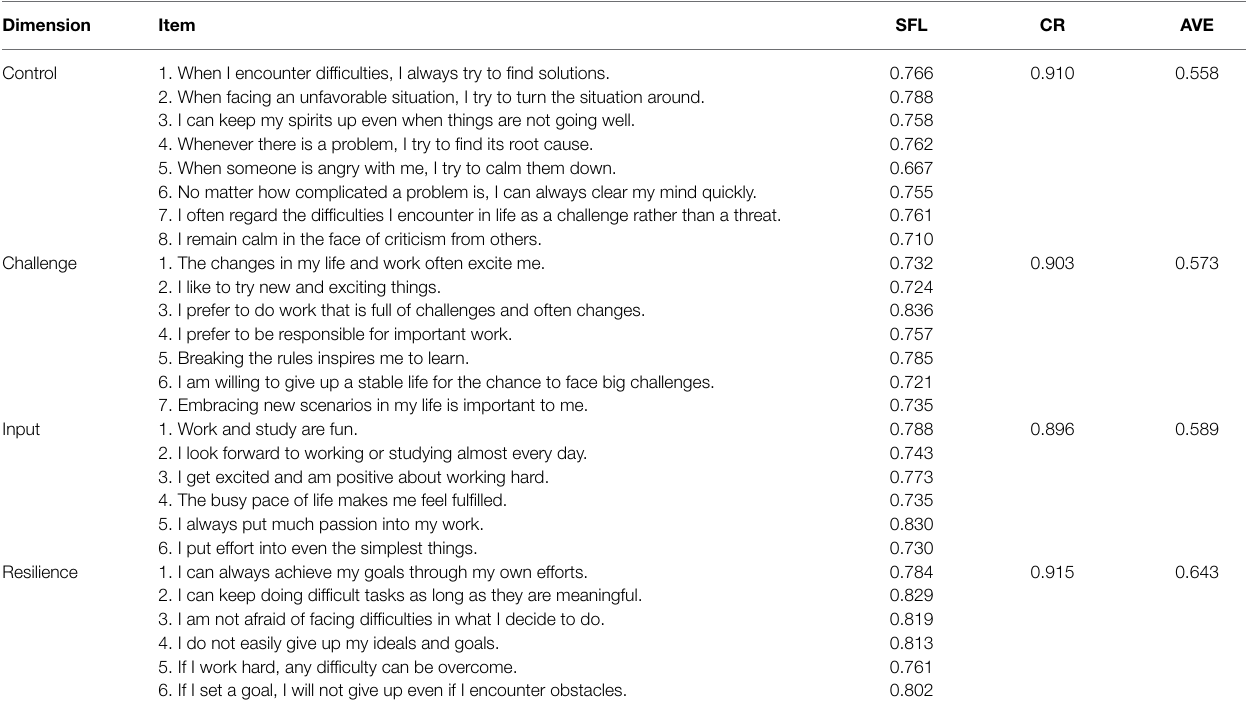
TABLE 1 | CFA of the hardiness scale. Dimension